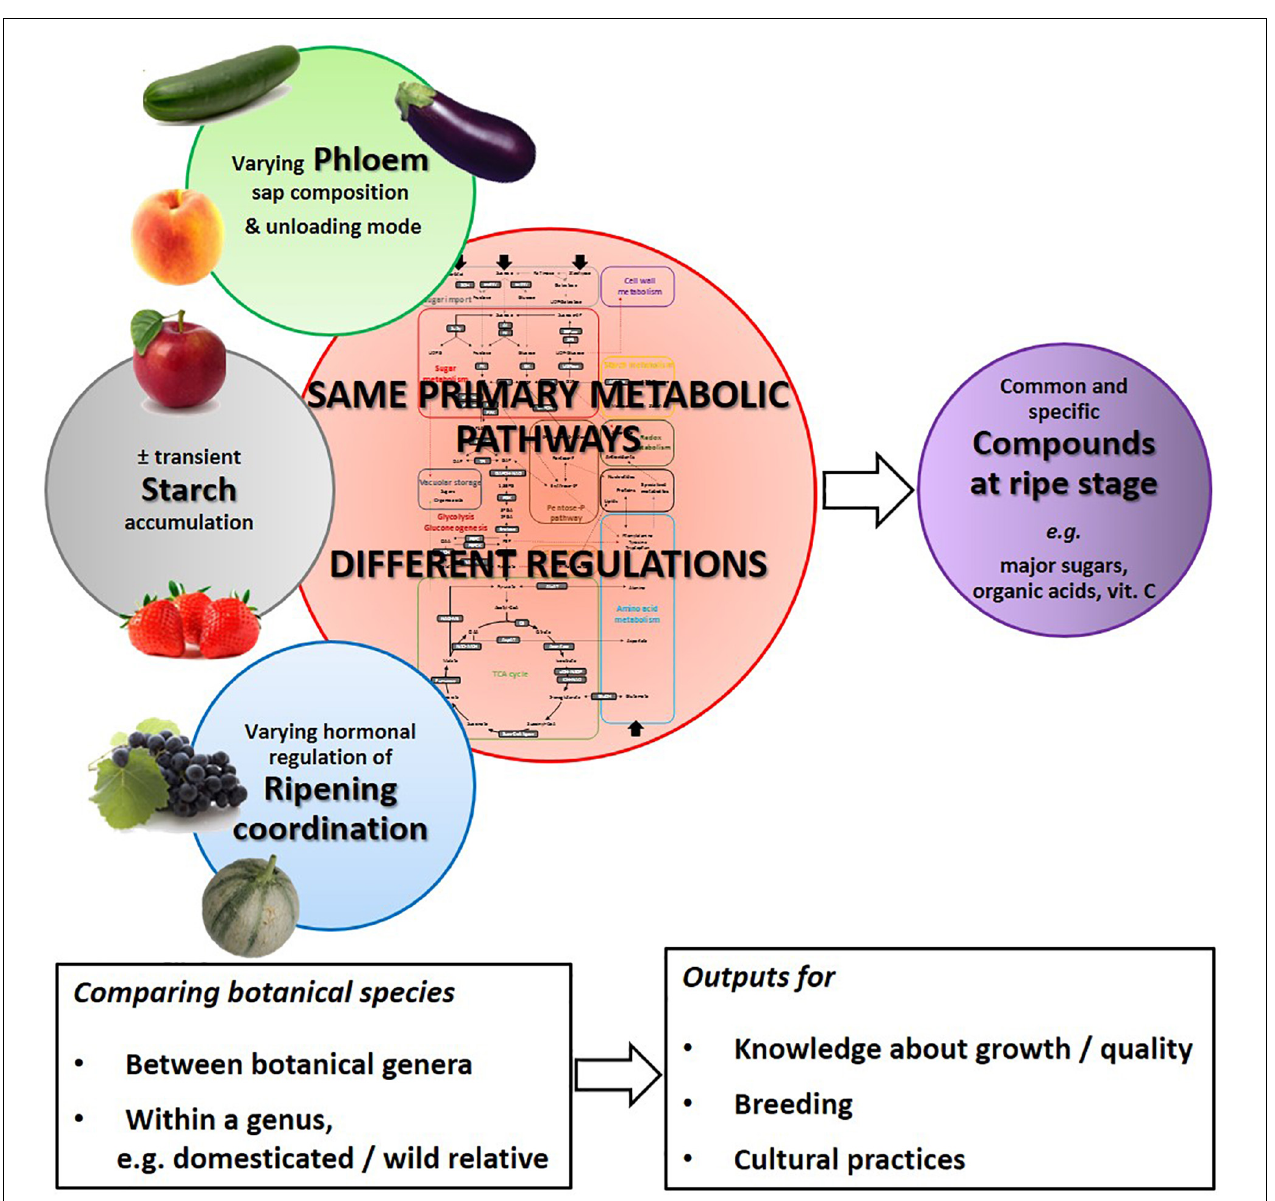
FIGURE 1 | Schema of the major physiological and metabolic differences and similarities between fleshy fruit species leading to varying fruit compositions at ripe